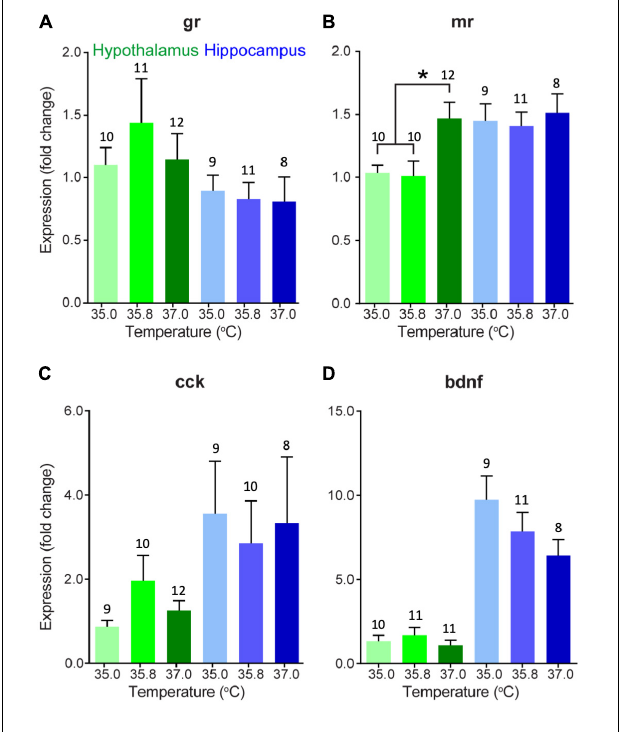
FIGURE 2 | Gene expression (mean fold change compared to 35 ◦ C hypothalamus group as a baseline) of (A) glucocorticoid receptor, (B) mineralocorticoid receptor, (C) cholecystokinin, and (D) brain-derived neurotrophic factor in the hypothalamus (green) and hippocampus (blue) of 15 day-old wood duck ducklings incubated at three different incubation temperatures. Gene expression was measured using quantitative PCR of brain tissue. Fold change is a 10-base fold change because results were transformed using a square exponent (i.e., 2 − (cid:49)(cid:49) Ct ). Error bars indicate standard error. Asterisk indicates significant effect of incubation temperature ( p < 0.05), as determined by a one-way ANOVA and Tukey HSD test. Numbers above bars indicate sample